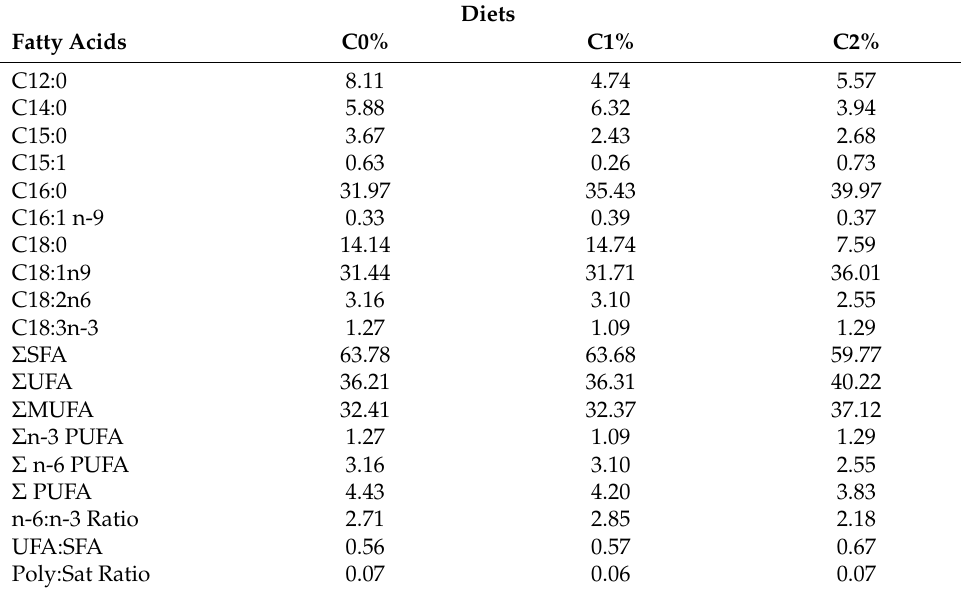
Table 2. Chemical and fatty acid composition of